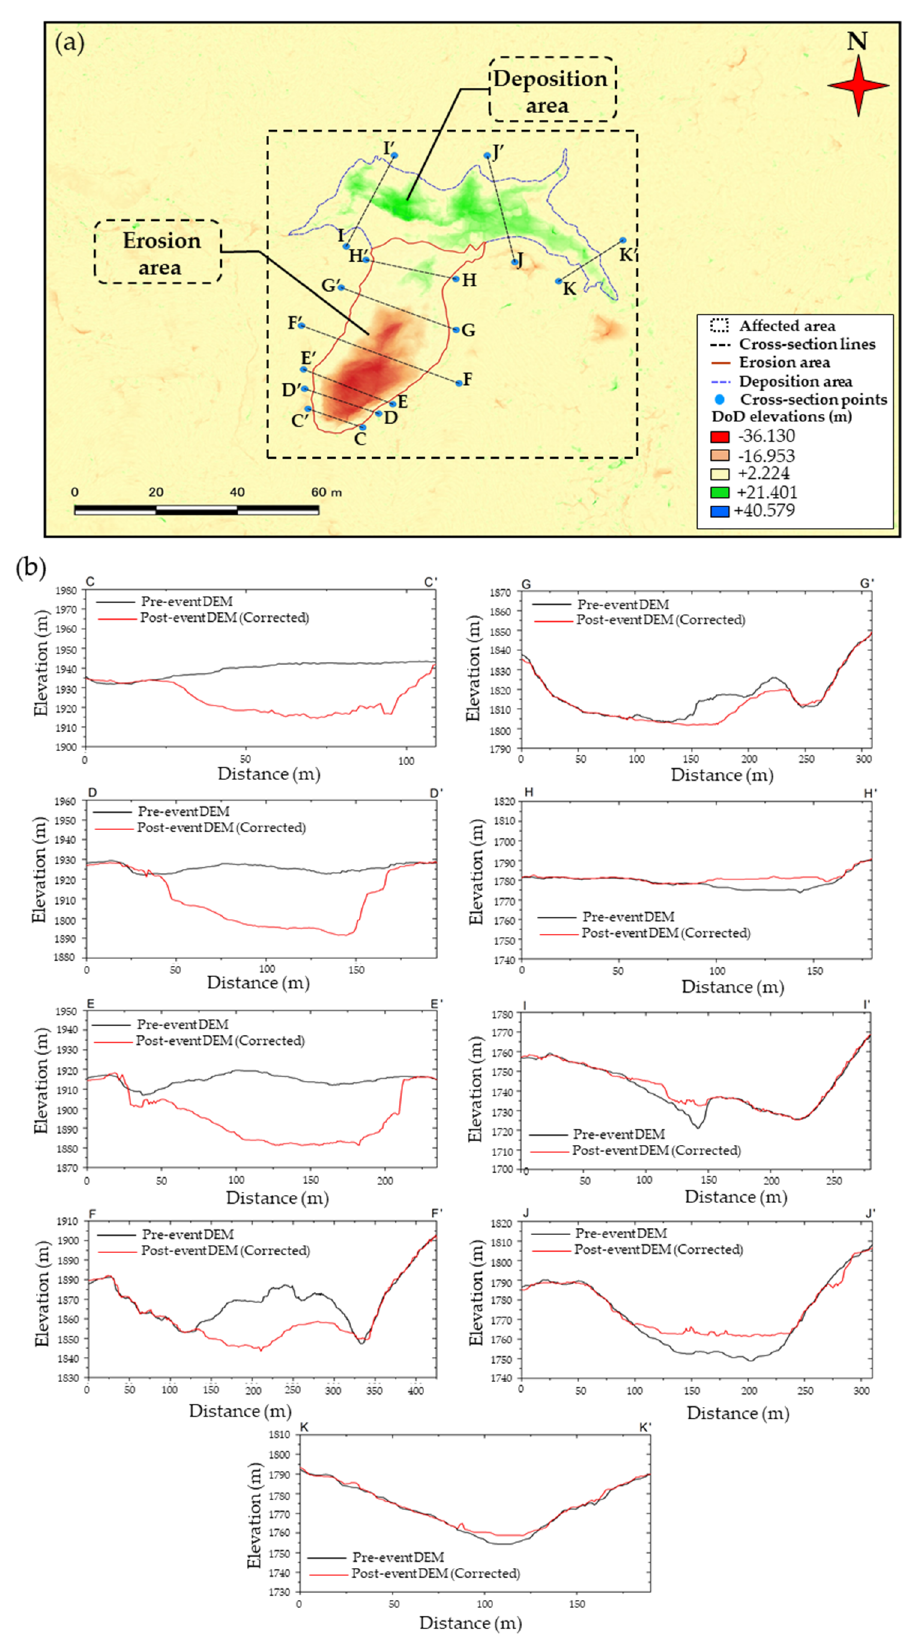
Figure 15. ( a ) DoD map obtained from the corrected DEMs presents the delineation of the landslide affected area and cross-section lines. ( b ) Cross-section profiles present the pre-and post-event surface difference throughout the landslide